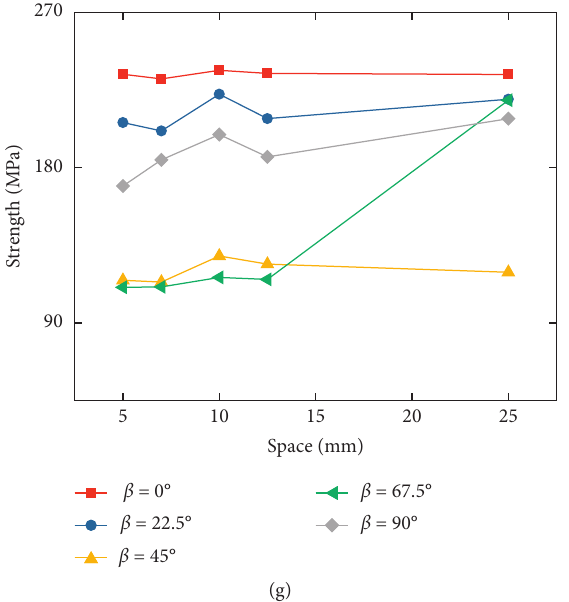
Figure 13: The cumulative distribution curve and average fragment size of layered rocks with different bedding space. (a–e) The distribution curve of 0 ° , 22.5 ° , 45 ° , 67.5 ° , and 90 ° samples, red: space � 5 mm, blue: space � 6.5mm, yellow: space � 10 mm, green: space � 12.5mm, and gray: space � 25mm. (f) Average fragment size vs. bedding space under different bedding angles. (g) Dynamic strength vs. bedding space under different bedding